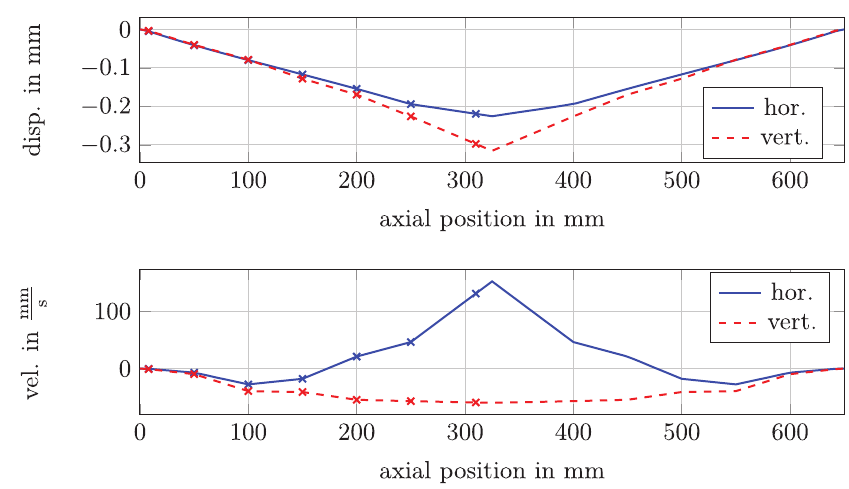
Figure 10. Extrapolated velocity fi eld of the string in horizontal and vertical direction, the measured points are marked.